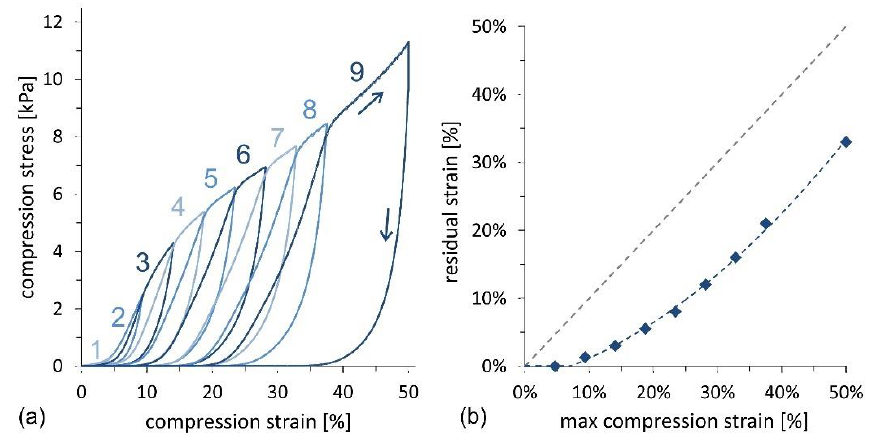
Figure 8. Mechanical compression tests of CNF foams produced by the stirred freezing process and a CNF concentration equal to 0.69 wt%. ( a ) Compression stress as function of compression strain including 9 cycles at increasing maximum compression strain up to 50%. The number beside each curve denote the cycle number. ( b ) Residual strain as function of the maximum compression strain as extracted from the data in ( a ). The limit for the elastic behavior, corresponding to zero residual stress, is found for a maximum compression strain of ~8%. The fitting line is a polynomial curve, while the dashed gray line is the quadrant bisector.